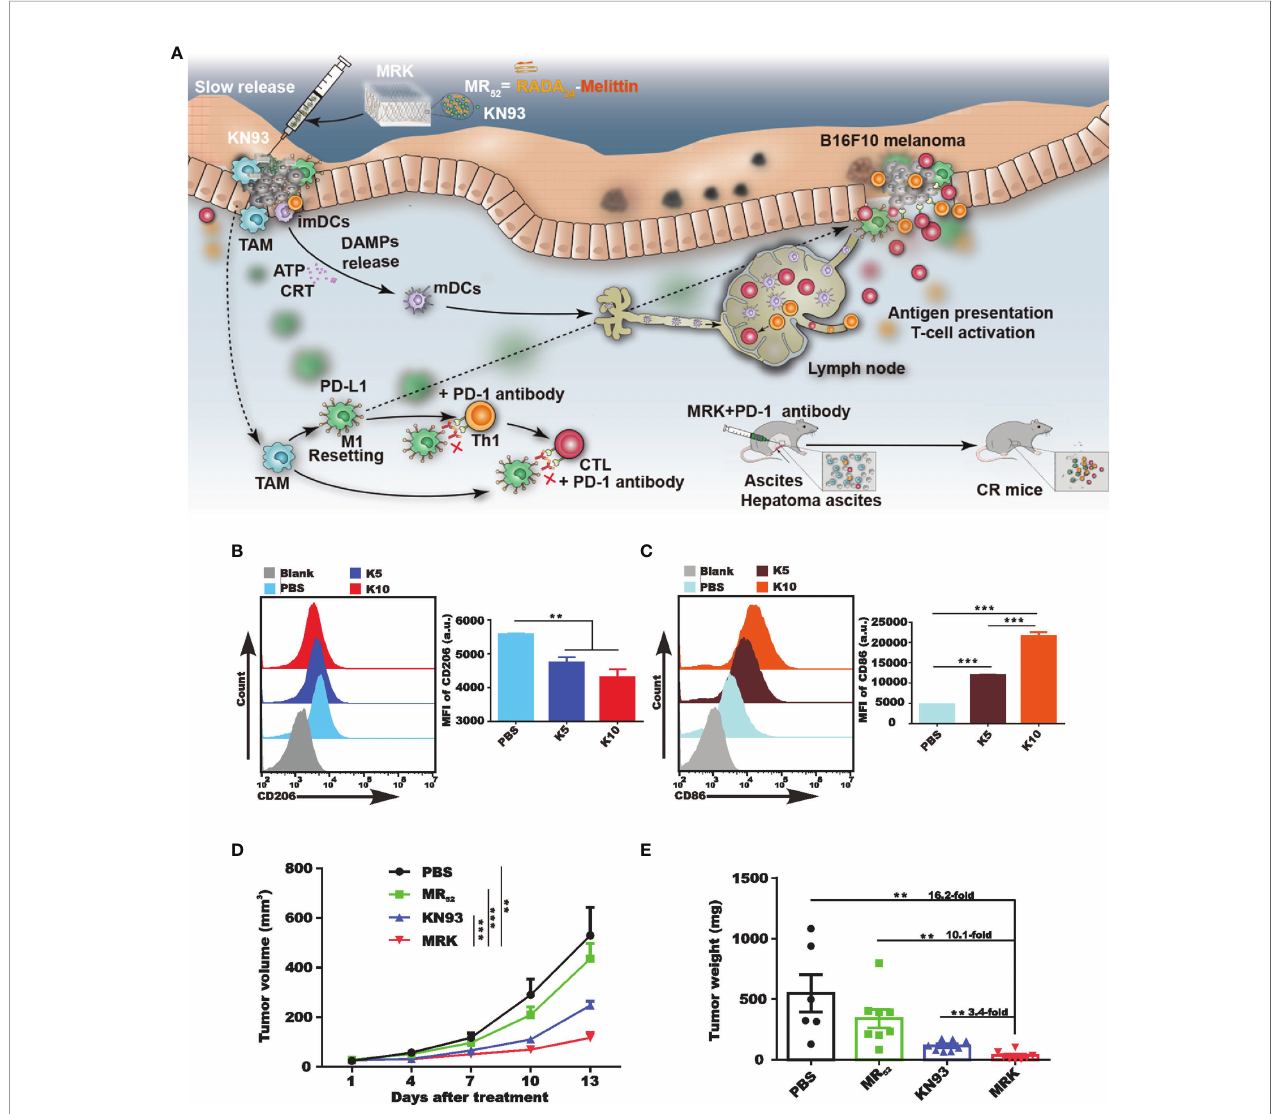
FIGURE 3 | In vivo activation of the immune system of tumor-bearing mice by MRK. (A) Schematic diagram summarizing the therapeutic effects of the MRK hydrogel alone or combined with anti-PD-1 antibodies. Subcutaneous injection of MRK stimulates dendritic cell maturation and T cell activation in the lymph nodes. Activated T cells eliminate tumor cells. MRK can also stimulate M1-type polarization of tumor-associated macrophages, activating Th1 cells and cytotoxic T lymphocytes. MRK combined with PD-1 alleviates hepatocellular ascites in mice. (B, C) Comparison of the production of M2-type macrophages (B) and dendritic cells (C) in each group. (D, E) Tumor volume (D) and weight (E) in different groups. Reprinted with permission from Theranostics (78). **P < 0.01, ***P <